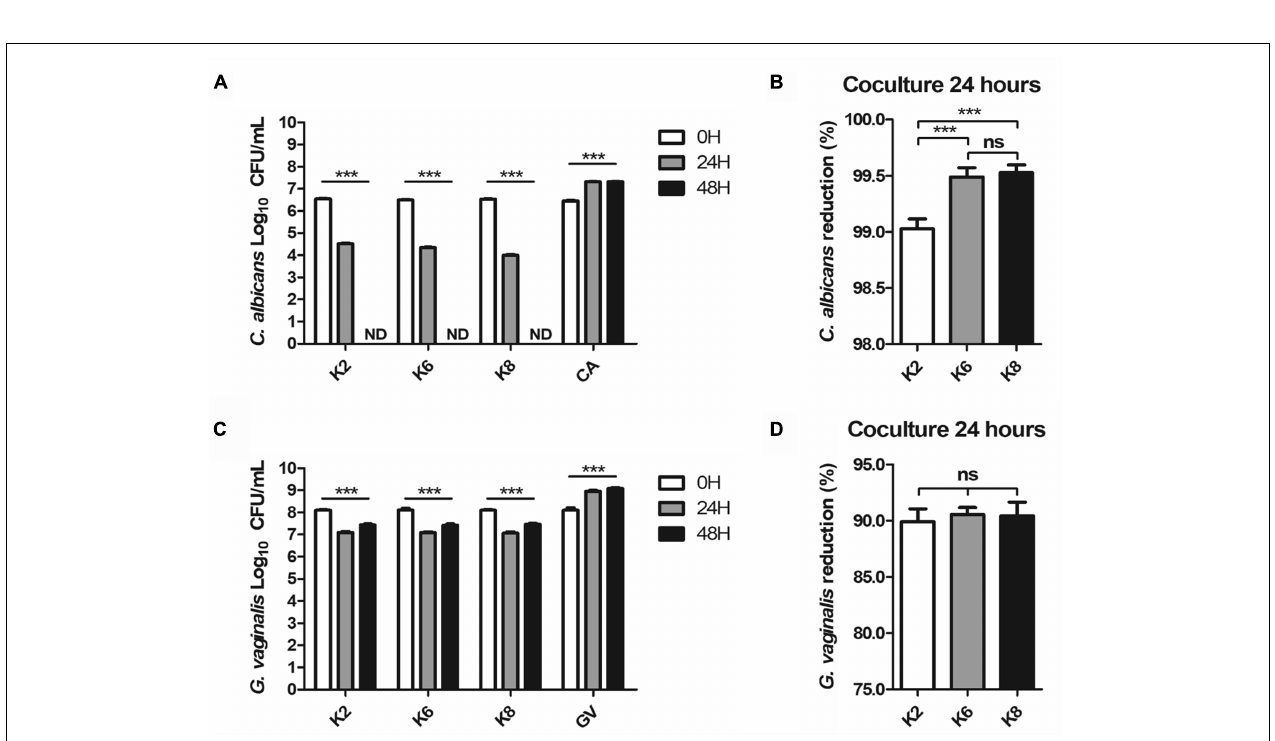
FIGURE 5 | (A,B) C. albicans and (C,D) G. vaginalis killing effects of live L. plantarum ATG-K2, ATG-K6, and ATG-K8 determined by a coculture method. Log 10 CFU/mL of each target pathogen measured in 24 h intervals are shown in (A,C) . Reduction rates of each target pathogen at the 24 h mark are shown in (B,C) . Data are expressed as mean ± SEM for four replicated experiments. Statistical significances are shown as ∗ p < 0.05, ∗∗ p < 0.01, and ∗∗∗ p < 0.001.